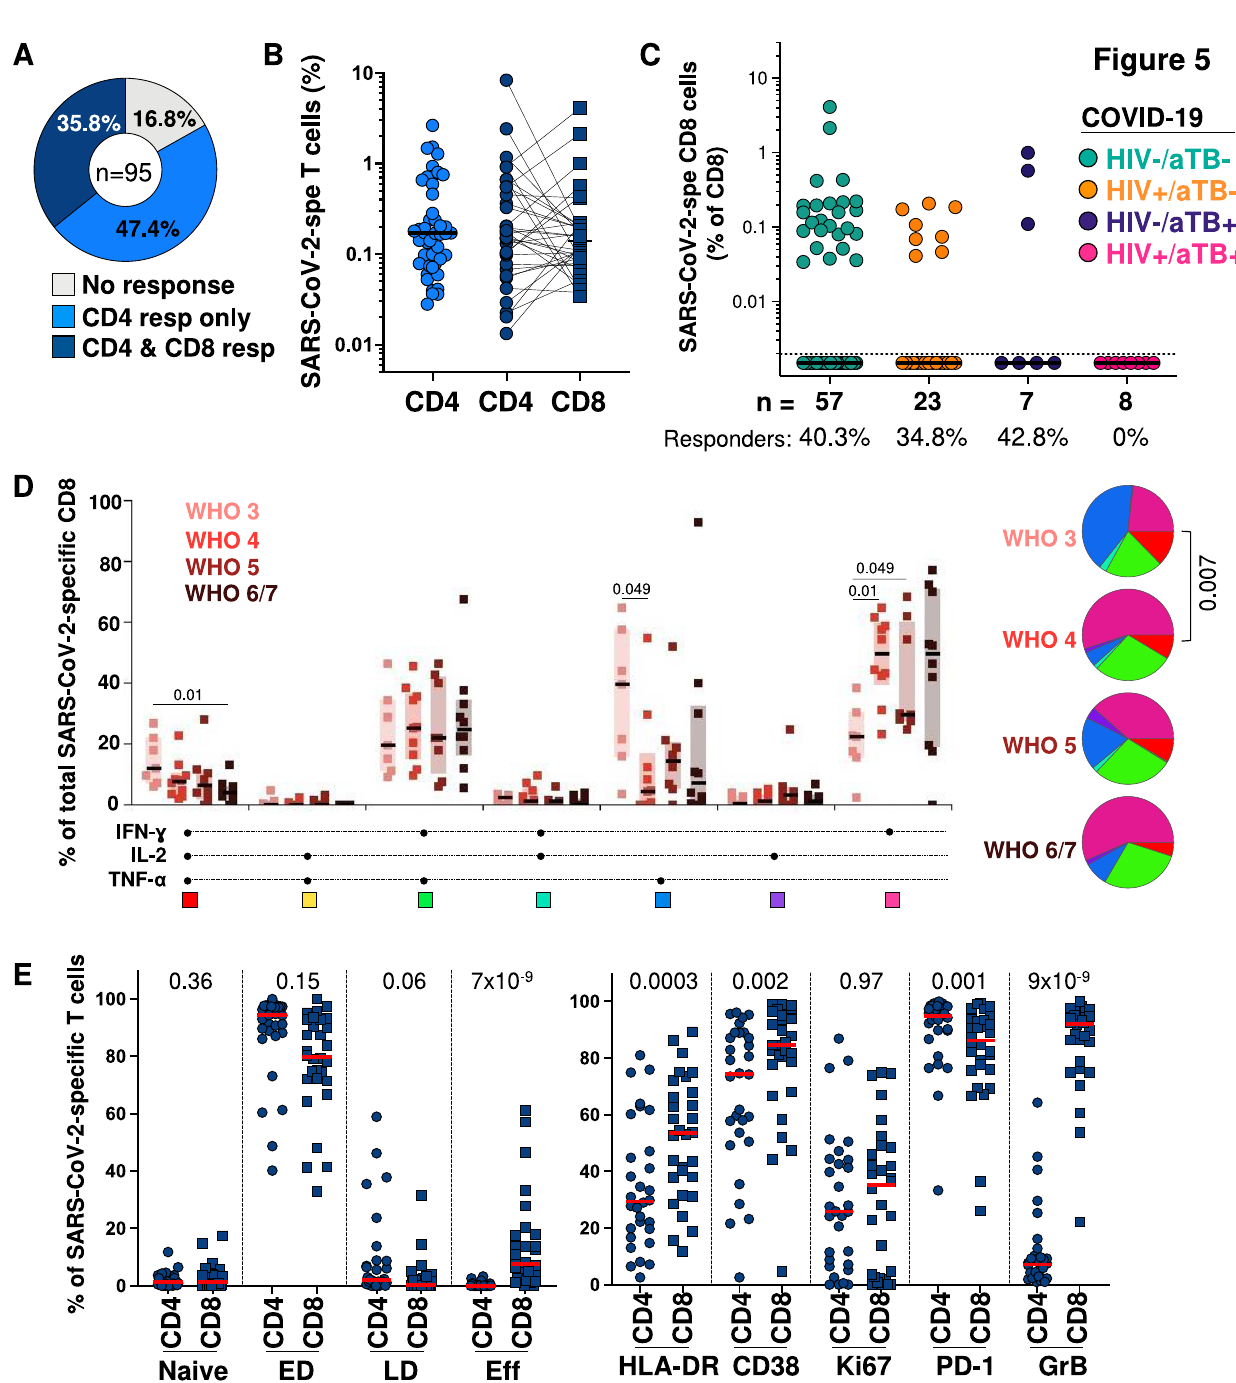
Fig. 5 | SARS-CoV-2 antigen-speci fi c CD8 T cell response in COVID-19 patients. A ProportionofCOVID-19patients( n =95)exhibitingadetectableSARS-CoV-2CD8 T cell response. B Comparison of the magnitude of SARS-CoV-2-speci fi c CD4 and CD8TcellsinCOVID-19patientsexhibitingaSARS-COV-2CD4Tcellsresponseinin absence of CD8responses( n =45,lightblue)and inpatientsexhibiting both aCD4 andCD8SARS-CoV-2responsetoSARS-CoV-2( n =34,darkblue). C Prevalenceand frequenciesofSARS-CoV-2-speci fi cCD8Tcellsin95COVID-19patientsstrati fi edby HIV and/or tuberculosis co-infection. D Polyfunctional pro fi le of SARS-CoV-2-